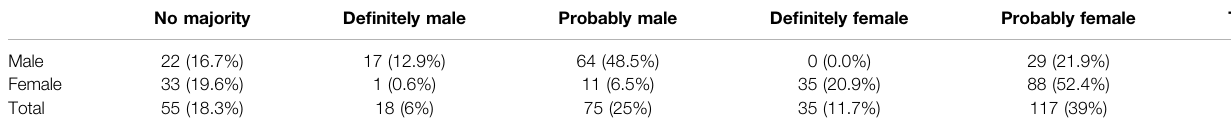
TABLE 2 | Results from the survey experiment indicate that humans are indeed not very good at predicting gender from text.